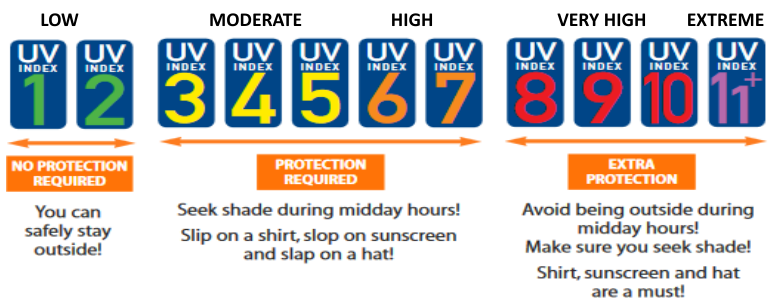
Figure 2. UV radiation exposure categories and recommended sun protection scheme (modified after